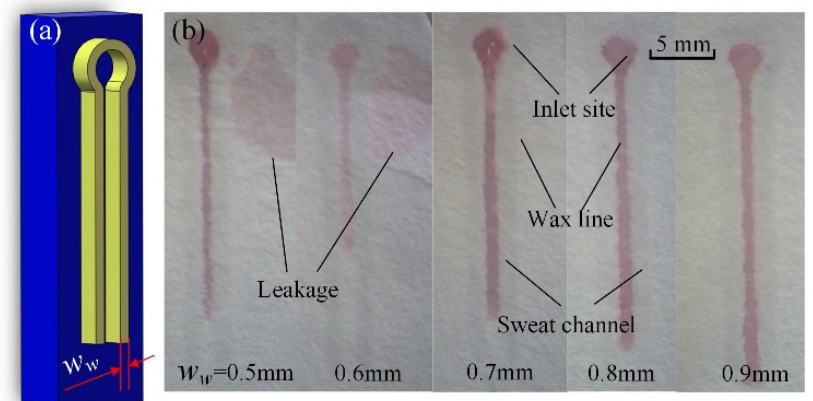
Figure 5. Sweat leakage experiment between neighboring wax lines with different widths: ( a ) mould for wax channels; ( b ) photo of channels with sweat.